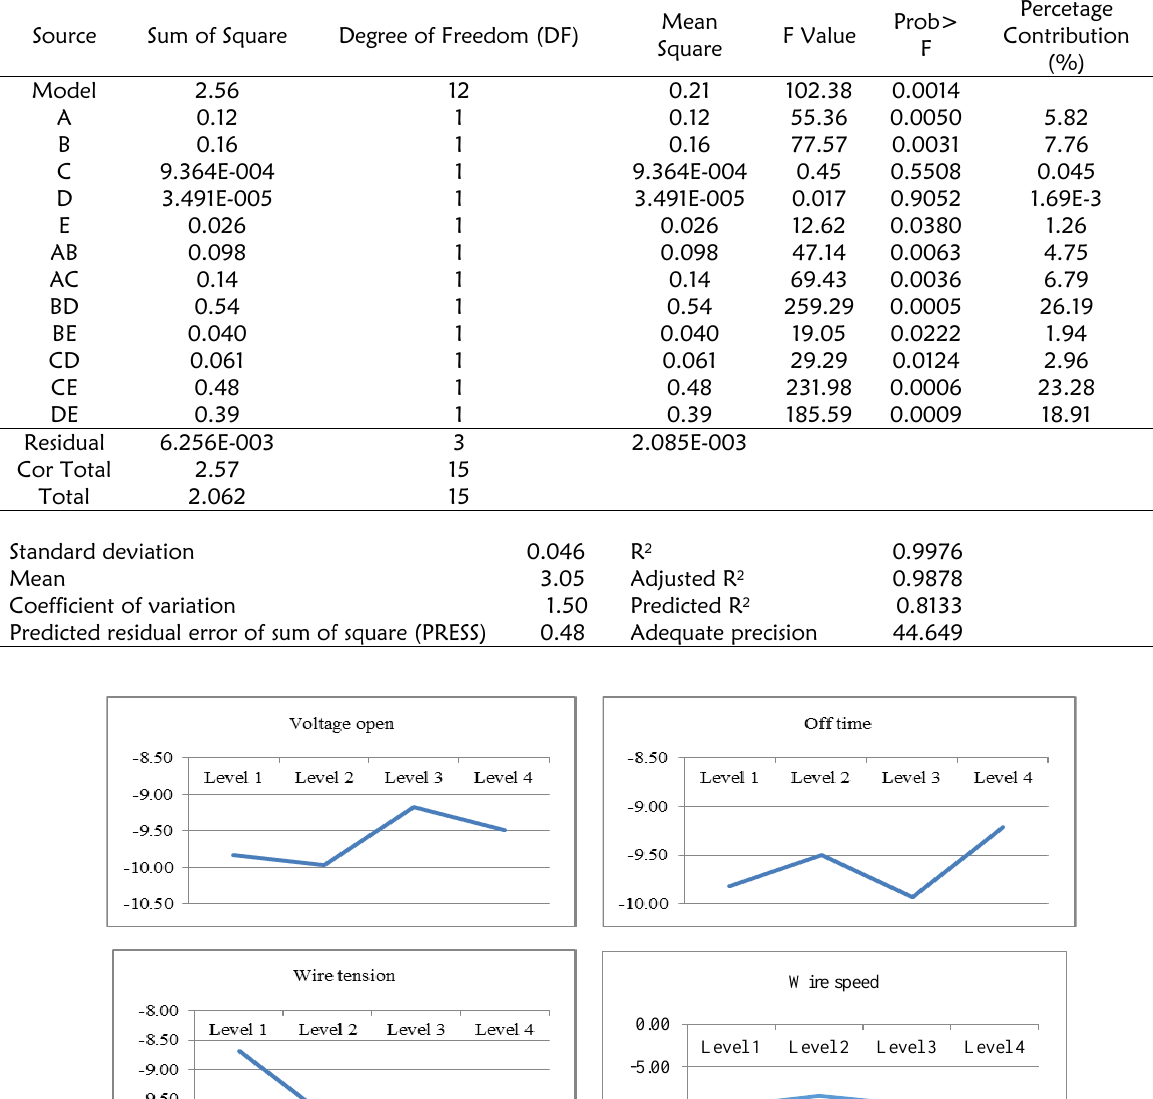
Table 4: ANOVA for average R a